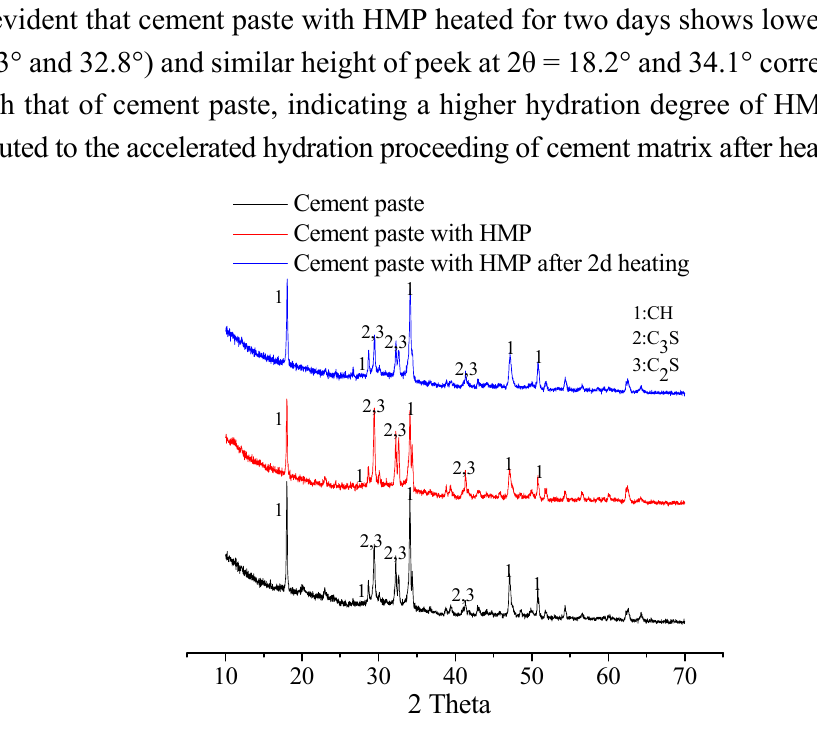
Figure 4. X-ray diffraction (XRD) spectra of